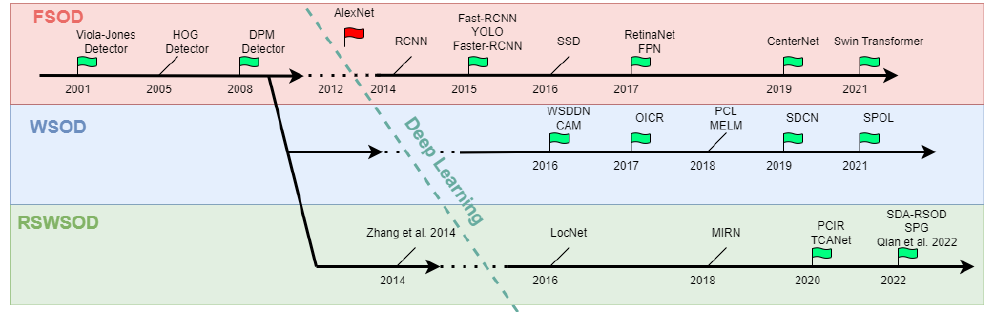
Figure 5. Timeline of the milestones in RSWSOD, with a comparison with FSOD [2,54] and WSOD [12] through the years. The flag symbol is used to represent milestones, while a simple line is used to denote other relevant methods. For the sake of clarity, not all methods have been reported